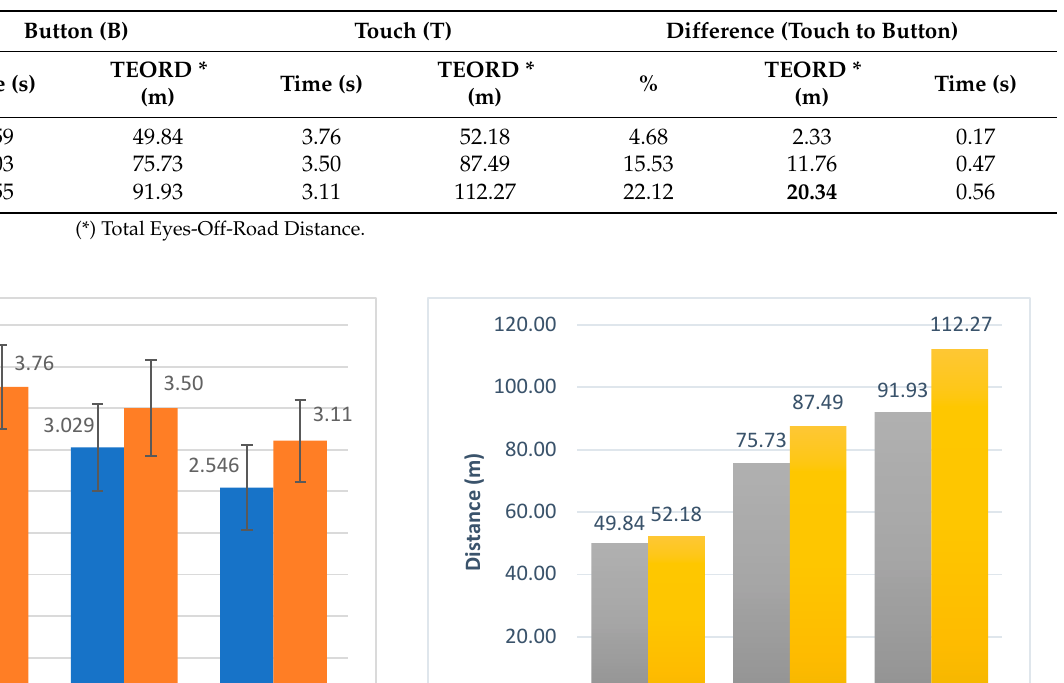
Table 3. Visual distraction and total eyes-off the road distances.